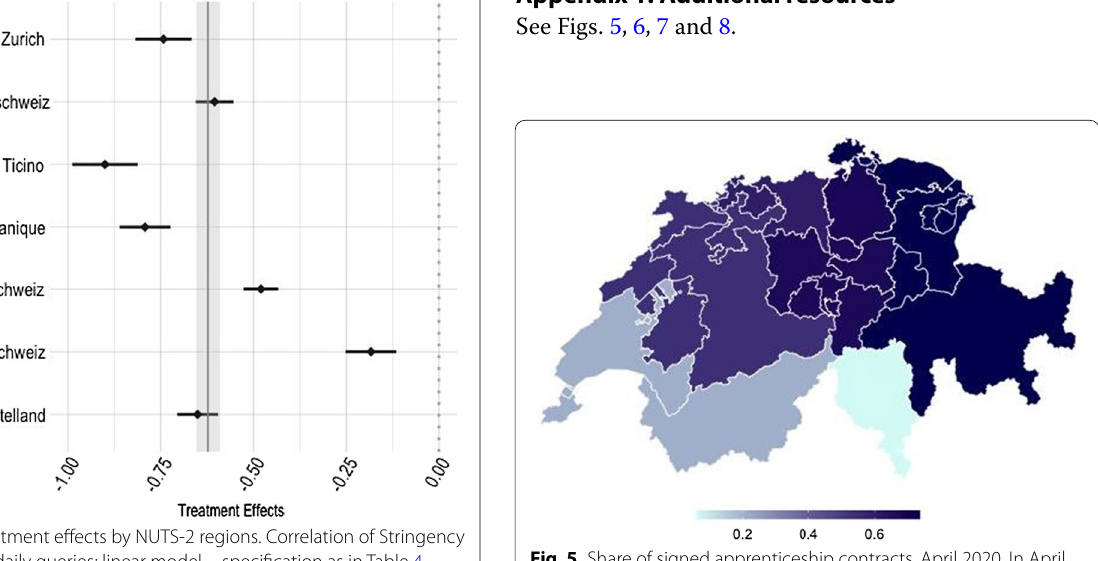
Fig. 5 Share of signed apprenticeship contracts, April 2020. In April 2020 as a share of the number of previous years’ final number of signed apprenticeship contracts within a NUTS-2 region